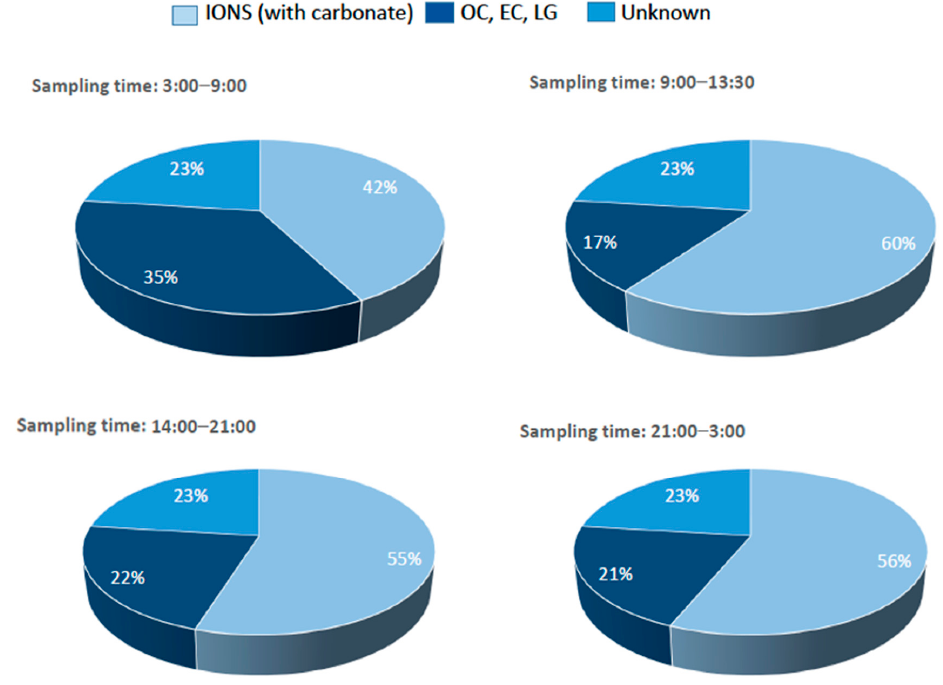
Figure 6. The percentage chemical composition of PM 2.5 in the di ff erent sampling intervals.